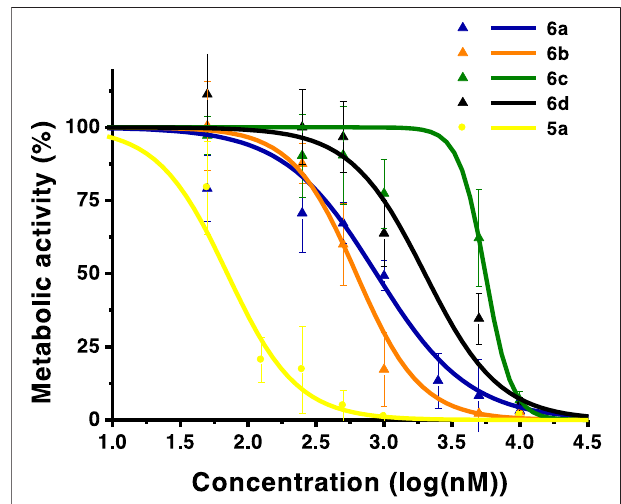
FIGURE 3 | Dose-response curves of OE19 esophageal adenocarcinomacells.Analysisperformed24 hafterPDT.Thegraphincludes monohydroxymethyl derivative 7a , diacid chlorins 6a – c , and the dihydroxymethyl compound 5a . Data points represent the mean ± SD.